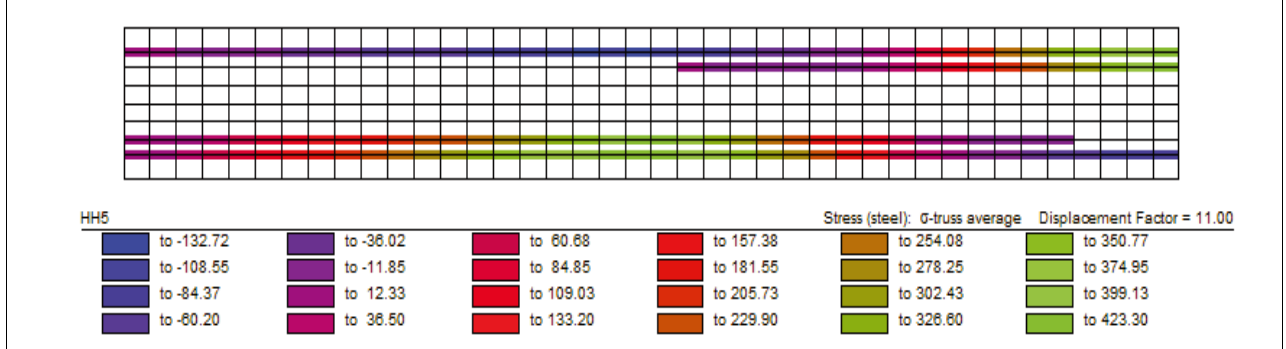
Figure 16 – Reinforcement stresses for beam